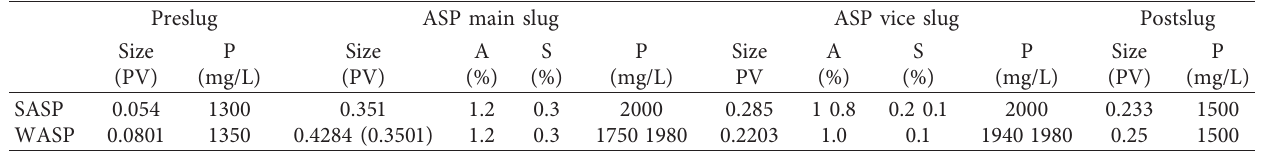
Table 16: Actual injection scheme.